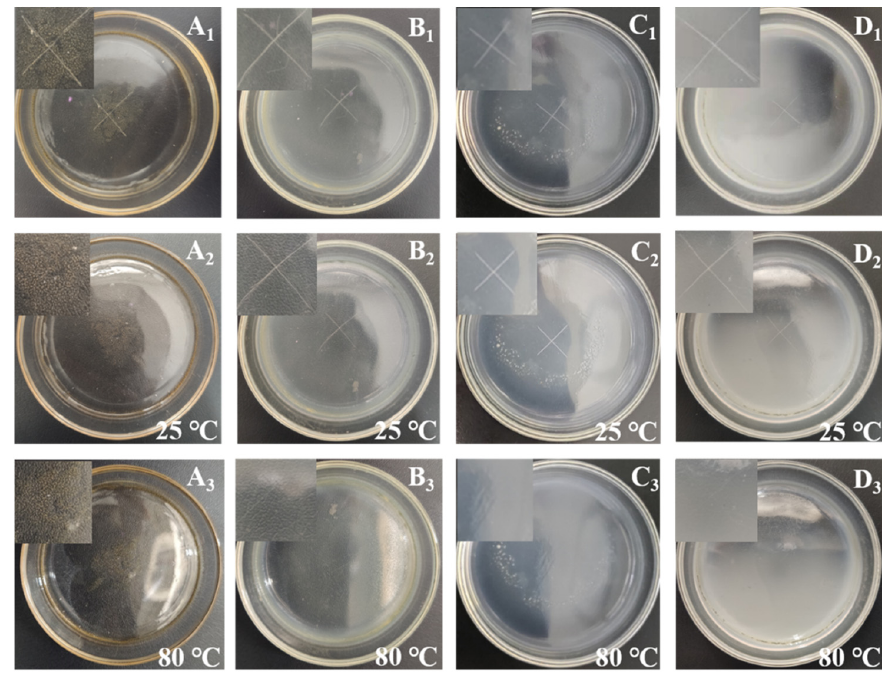
Figure 8. Images of a self-healing performance test for a coating scratch: P(CTFE- alt -IBVE)/MFWPU composite coatings prepared with different mass feed ratios of MFWPU versus IBVE: 1:1 ( A ), 1:3 ( B ), 1:4 ( C ) and 1:5 ( D ) at the initial time ( A 1 – D 1 ), 15 h at 25 °C ( A 2 – D 2 ) and 2 h at 80 °C ( A 3 – D 3 ).